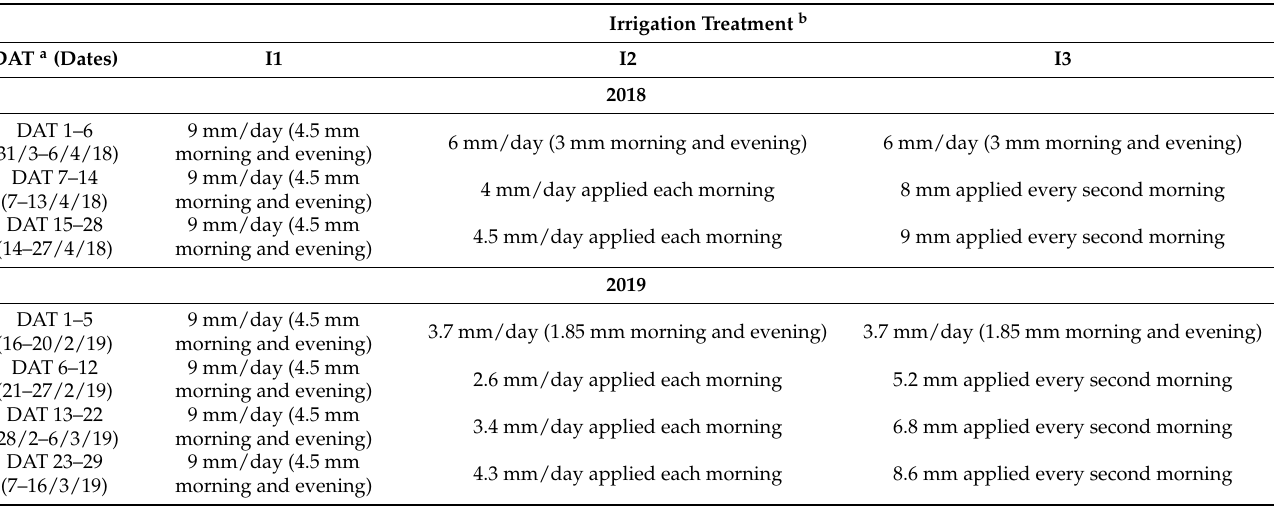
Table 2. Irrigation treatments applied to lettuce crops grown over two seasons at National University of Laos, Nabong, Xaithany district, Vientiane Capital Province, Laos.